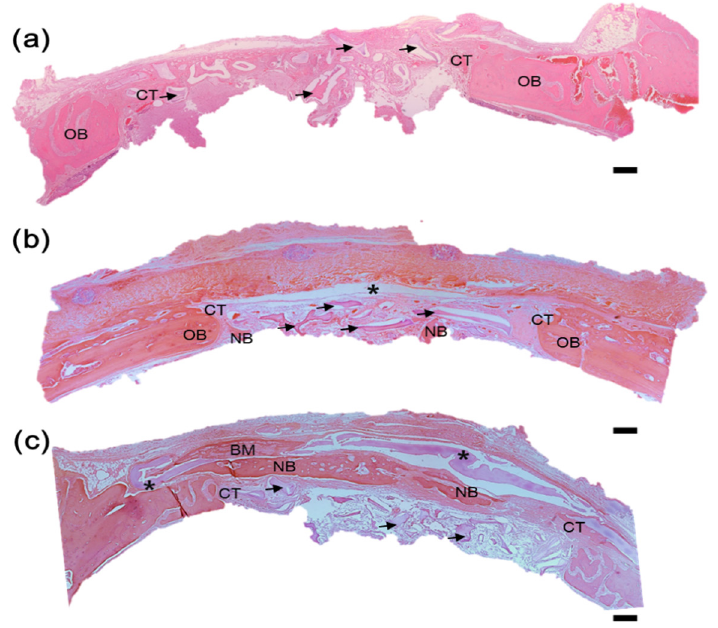
Figure 9. Histological sections stained with H&E show the cranial defect and surrounding cranial tissue, ( a ) covered without membrane, ( b ) covered with collagen membrane (asterisk), and ( c ) covered with FC/GC-BGM membrane (asterisk) after 2weeks (OB: original bone, CT: connective tissue, NB: newly formed bone, BM: bone marrow, BGM: black arrow). Scale bar indicates 100 μ m.